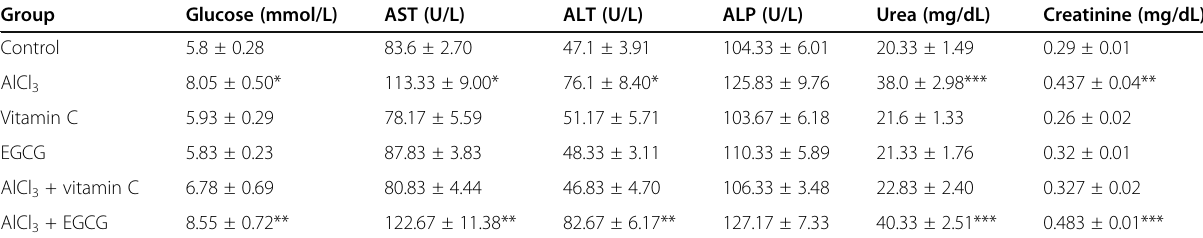
Table 1 Effect of EGCG on biochemical parameters of the rats Group